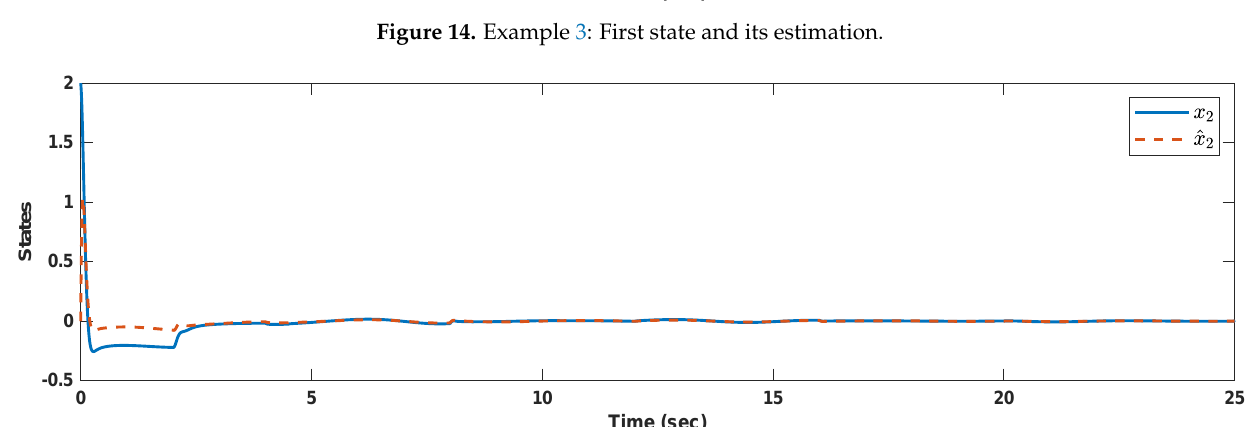
Figure 14. Example 3: First state and its estimation.